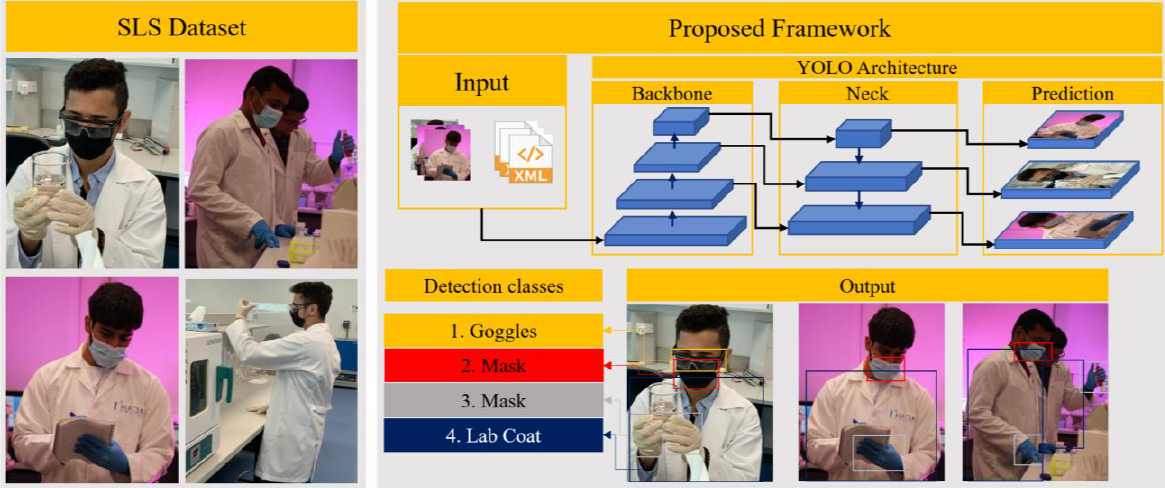
Figure 2. Overview of the proposed system (correct the arrows).